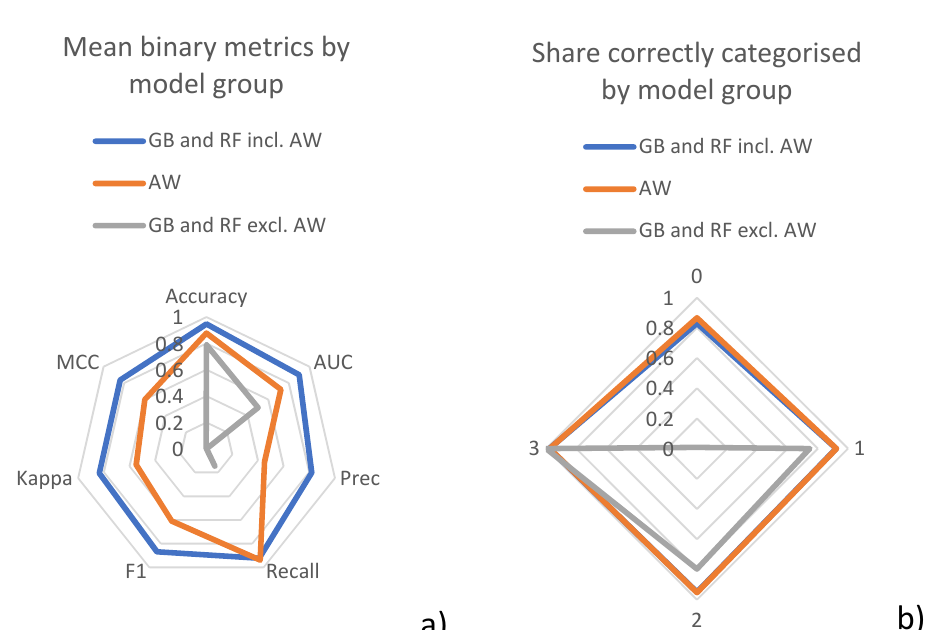
Figure 2. Results of Table 4 grouped by model type and whether the average weekly data (AW) were used or not. Part ( a ) shows the results for binary metrics and ( b ) for the categorised results. Category “0” corresponds to the share of correctly assigned categories; “1” counts direct neighbour categories (e.g., “very low”–“medium” are still correct if “low” was the true value); “2” includes neighbours once removed; “3” neighbours twice removed.